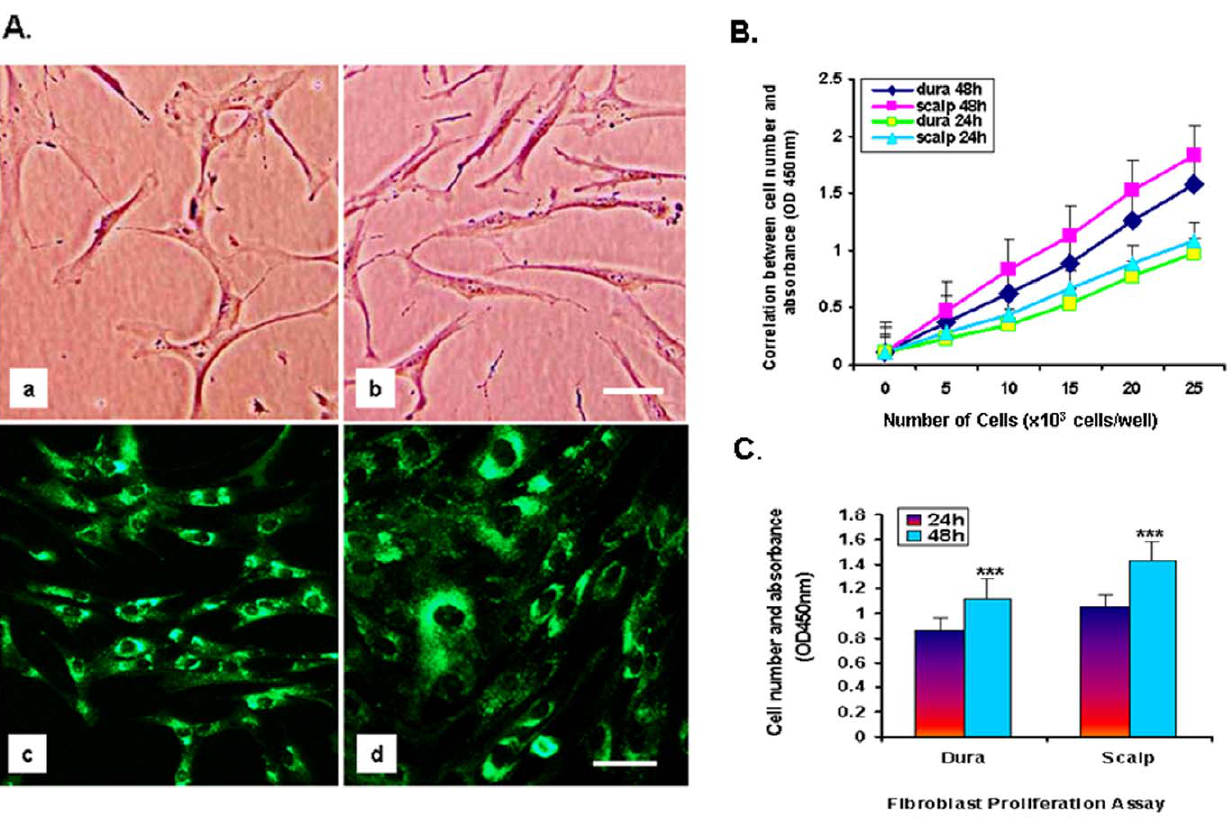
Figure 1. Fibroblast characterization: FSP-1 protein expression by immunofluorescence staining and cell proliferation assay in dura and scalp. A. The morphology of postmortem fibroblast cells generated from (a) dura and (b) scalp. Cultured cells from both sources macroscopically looked similar to what is seen in living skin fibroblast cells, with more enriched cytoplasm and spindle-shaped nuclei under phase- contrast microscopy. Cells from (c) dura and (d) scalp express cytoplasmic Fibroblast Specific Protein-1 (FSP-1) (green). Original scale bars=35 m m. B. Results from cell proliferation assay in 8 fibroblast cell lines (dura and scalp from 4 individuals) in five different densities. Cell viability was determined in 24 hrs and 48 hrs by WST-8 assay. Values are the mean of results from six wells. Bars 6 SE. Scalp fibroblast cell lines grew 1.27-fold faster in the same period than dura fibroblast cells. C. Differences in cell proliferation between scalp and dura by one-way ANOVA; scalp cell growth was significantly more rapid than dura cell growth at 24 hr and 48 hr intervals [F (1, 46)=12.94, p , 0.008].